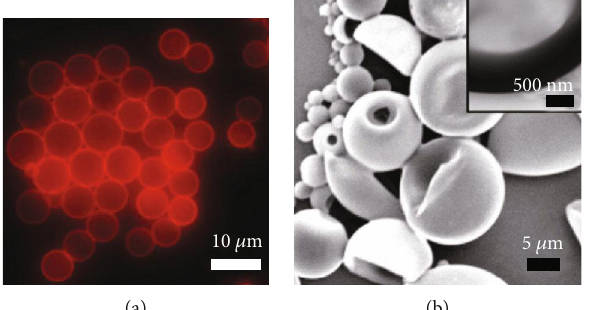
Figure 37: (a) Fluorescence microscopy and (b) SEM and TEM (inset) micrographs of PDLLA microcapsules labeled with 1 wt% Nile Red relative to polymer. The microcapsules were obtained through evaporation of organic solvent from emulsion droplets containing 5 mg/mL PDLLA and 3mg/mL Aerosol OT [115].